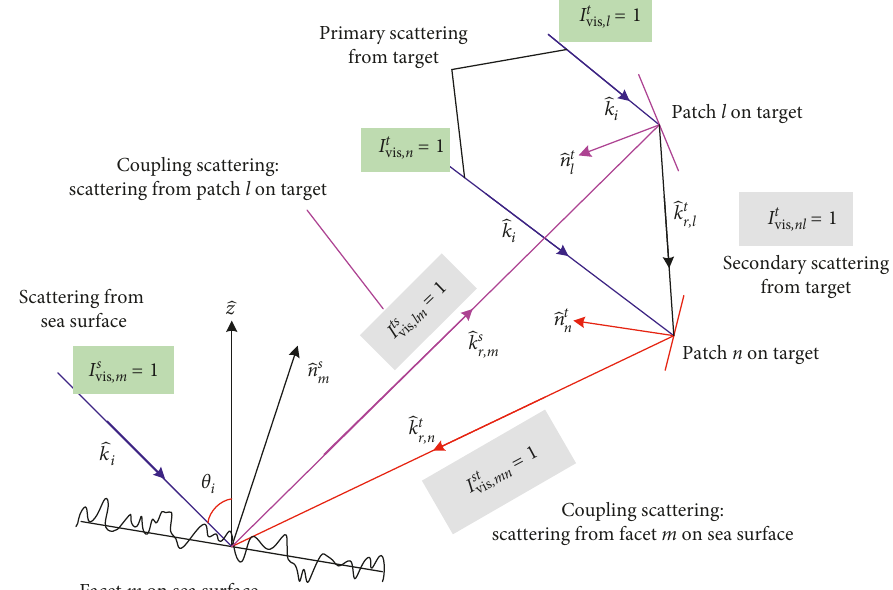
Figure 1: Diagram of the scattering contributions from the composite scene of sea surface and